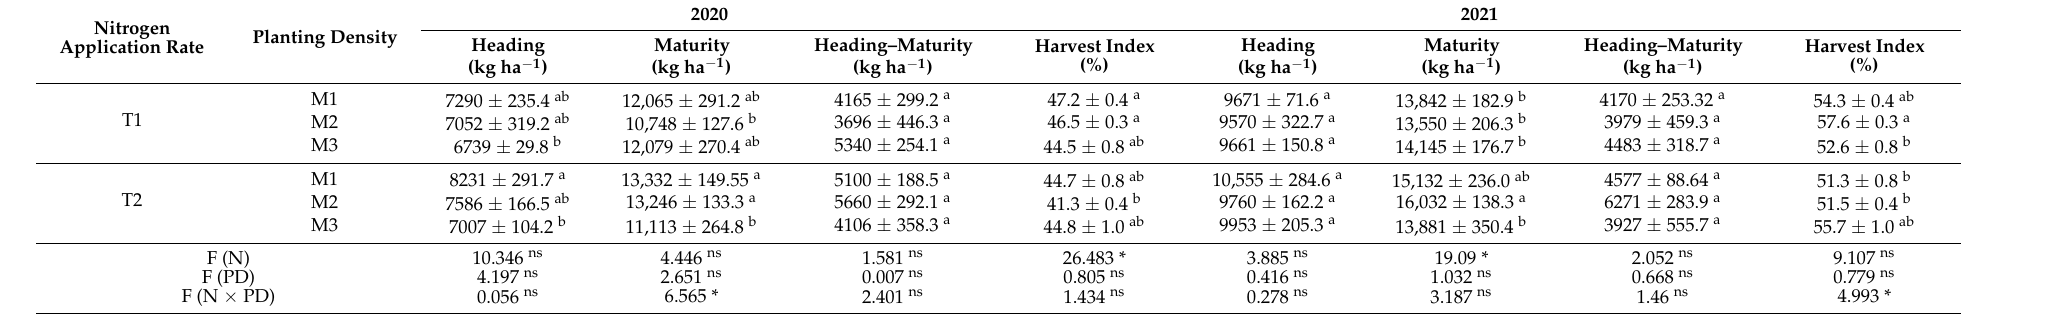
Table 3. Dry matter accumulation of rice under different nitrogen applications and planting densities.